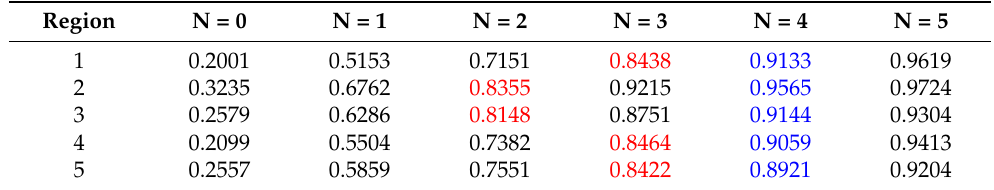
Figure 7. F1-measure curves of five regions by comparing the detection results of proposed method for different samples within N pixels. Table 3. F1-measure of five regions by comparing the detection results of proposed method for different